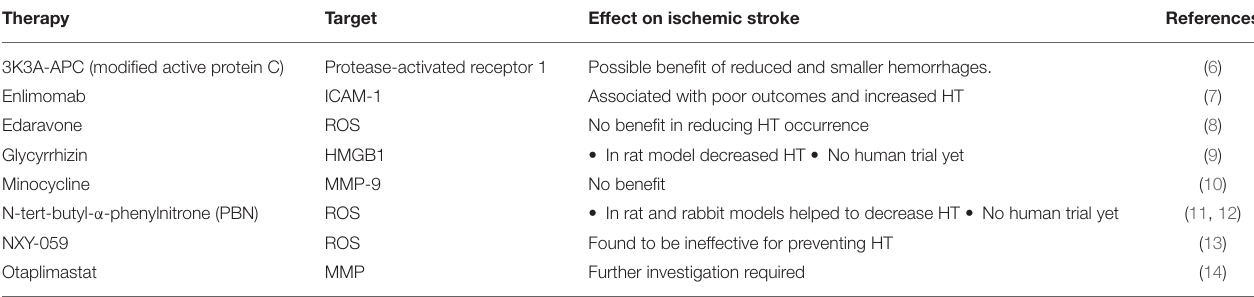
TABLE 3 | Therapeutic targets in acute ischemic stroke focused on modulating HT.